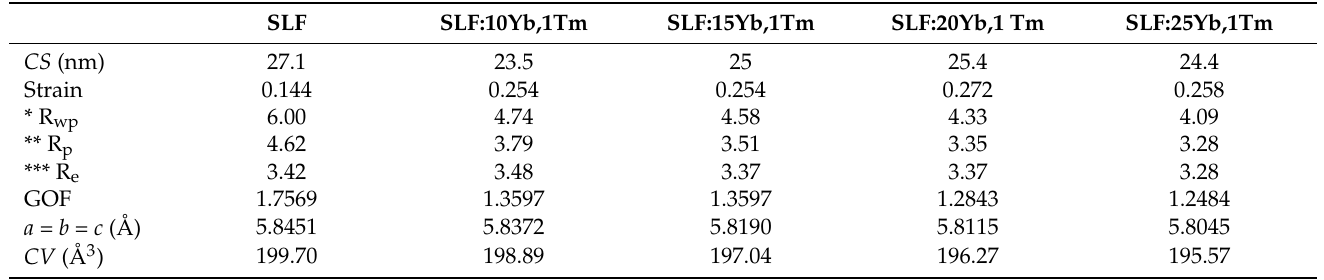
Table 1. Results of the structural analysis by using WPF refinement of SLF:xYb 3+ , 1 mol%Tm 3+ nanophosphors.